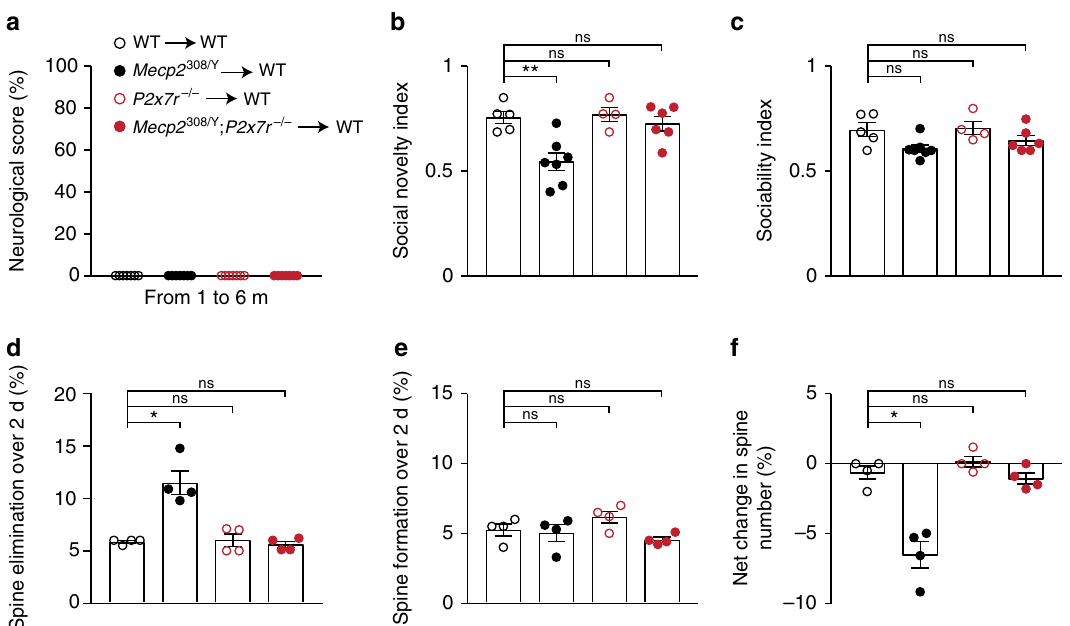
Fig. 5 Leukocyte P2X7Rs mediate social behavior de fi cits and cortical spine loss. a Neurological scores measured in WT, Mecp2 308/Y , P2x7r – / – and Mecp2 308/Y ; P2x7r − / − chimeric mice ( n = 7 mice per group). b , c Social novelty ( b ; n = 5, 7, 4, 6 mice; P = 0.0029, 0.9988, 0.9718) and sociability ( c ; n = 5, 7, 4, 6 mice; P = 0.0766, 0.9993, 0.5508) index measured in various chimeric mice. d – f Quanti fi cation of spine elimination ( d ; WT, 5.88 ± 0.13; Mecp2 308/Y , 11.53 ± 1.12, P = 0.0286 vs. WT; P2x7r – / – , 6.03 ± 0.59, P > 0.9999 vs. WT; Mecp2 308/Y ; P2x7r – / – , 5.60 ± 0.29, P = 0.7714 vs. WT), spine formation ( e ; WT, 5.25 ± 0.43; Mecp2 308/Y , 5.03 ± 0.59, P = 0.8571 vs. WT; P2x7r – / – , 6.18 ± 0.43, P = 0.1714 vs. WT; Mecp2 308/Y ; P2x7r – / – , 4.55 ± 0.19, P = 0.2857 vs. WT) and changes in total spine number ( f ; WT, − 0.63 ± 0.47; Mecp2 308/Y , − 6.53 ± 0.96, P = 0.0286 vs. WT; P2x7r – / – , 0.15 ± 0.38, P = 0.4857 vs. WT; Mecp2 308/Y ; P2x7r – / – , − 1.05 ± 0.40, P = 0.6571 vs. WT) in chimeric mice ( n = 4 mice per group). Data are presented as mean ±